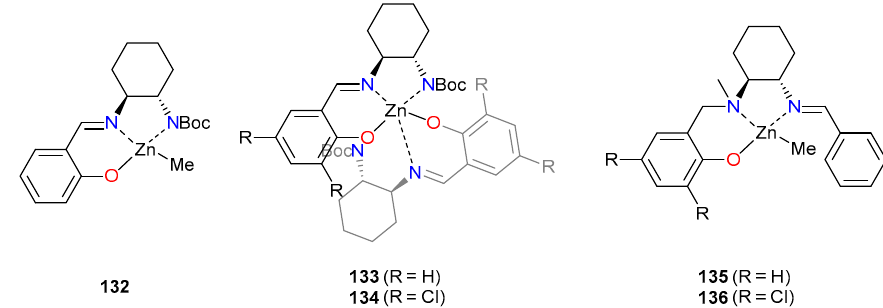
Figure 23. Zn complexes based on diaminocyclohexane-derived ligands [79].